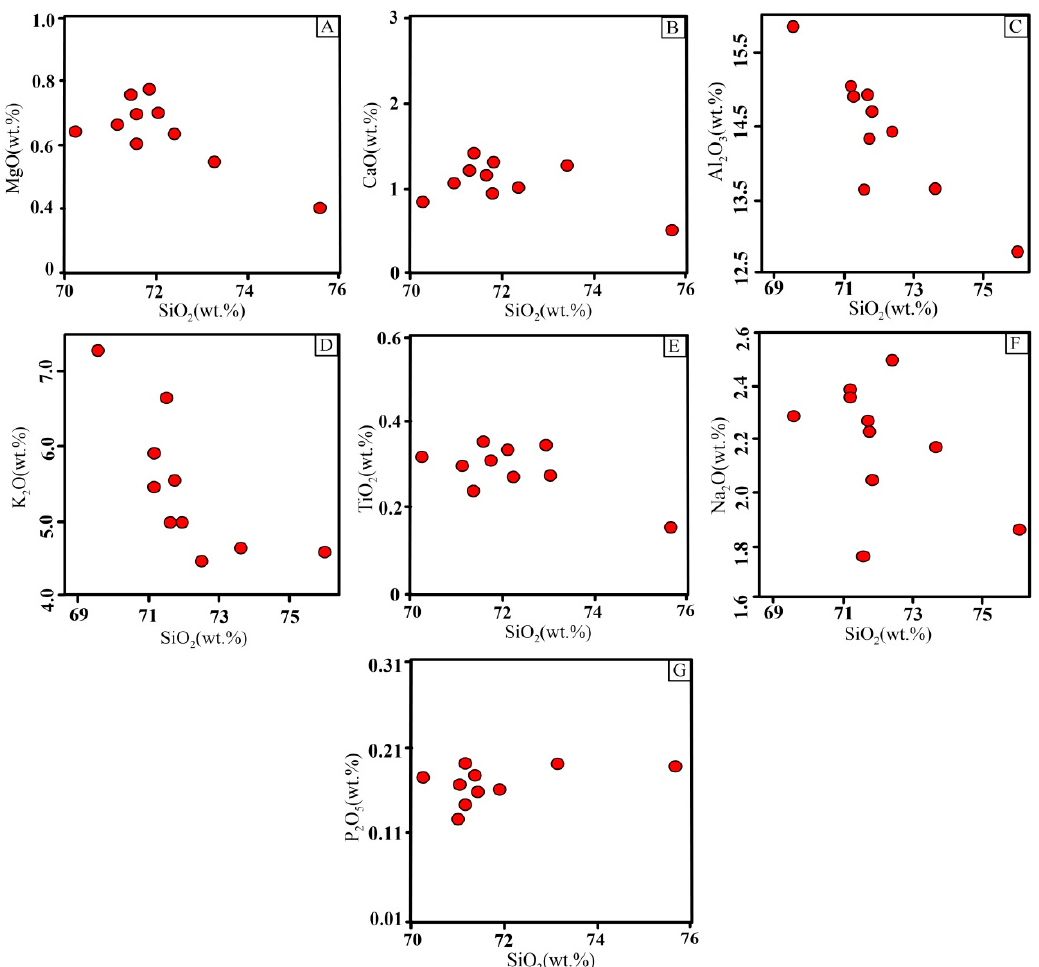
Figure 5. Harker variation diagrams; silica (SiO 2 wt.%) plotted against a range of major oxides (in wt.%) for the granites of the Tagu area. ( A ). MgO is negatively correlated with SiO 2 ; ( B ). CaO is negatively correlated with SiO 2 ; ( C ). Al 2 O 3 is negatively correlated with SiO 2 ; ( D ). K 2 O is negatively correlated with SiO 2 ; ( E ). TiO 2 is negatively correlated with SiO 2 ; ( F ). NaO 2 is negatively correlated with SiO 2 ; ( G ). P 2 O 5 is slightly positively correlated with SiO 2 .